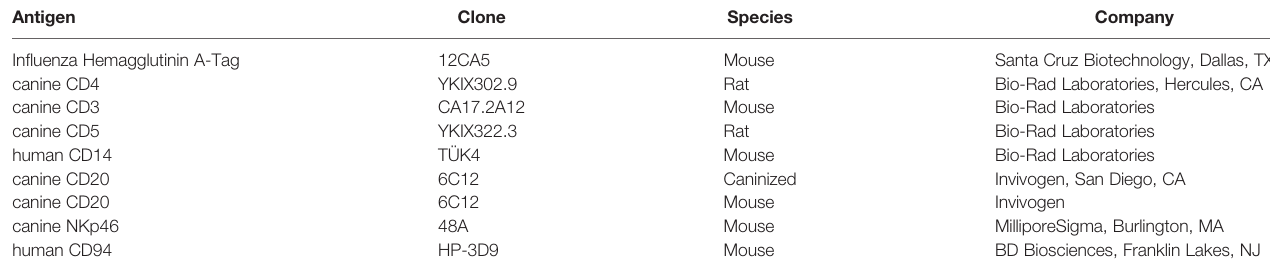
TABLE 1 | Commercially available mAbs.